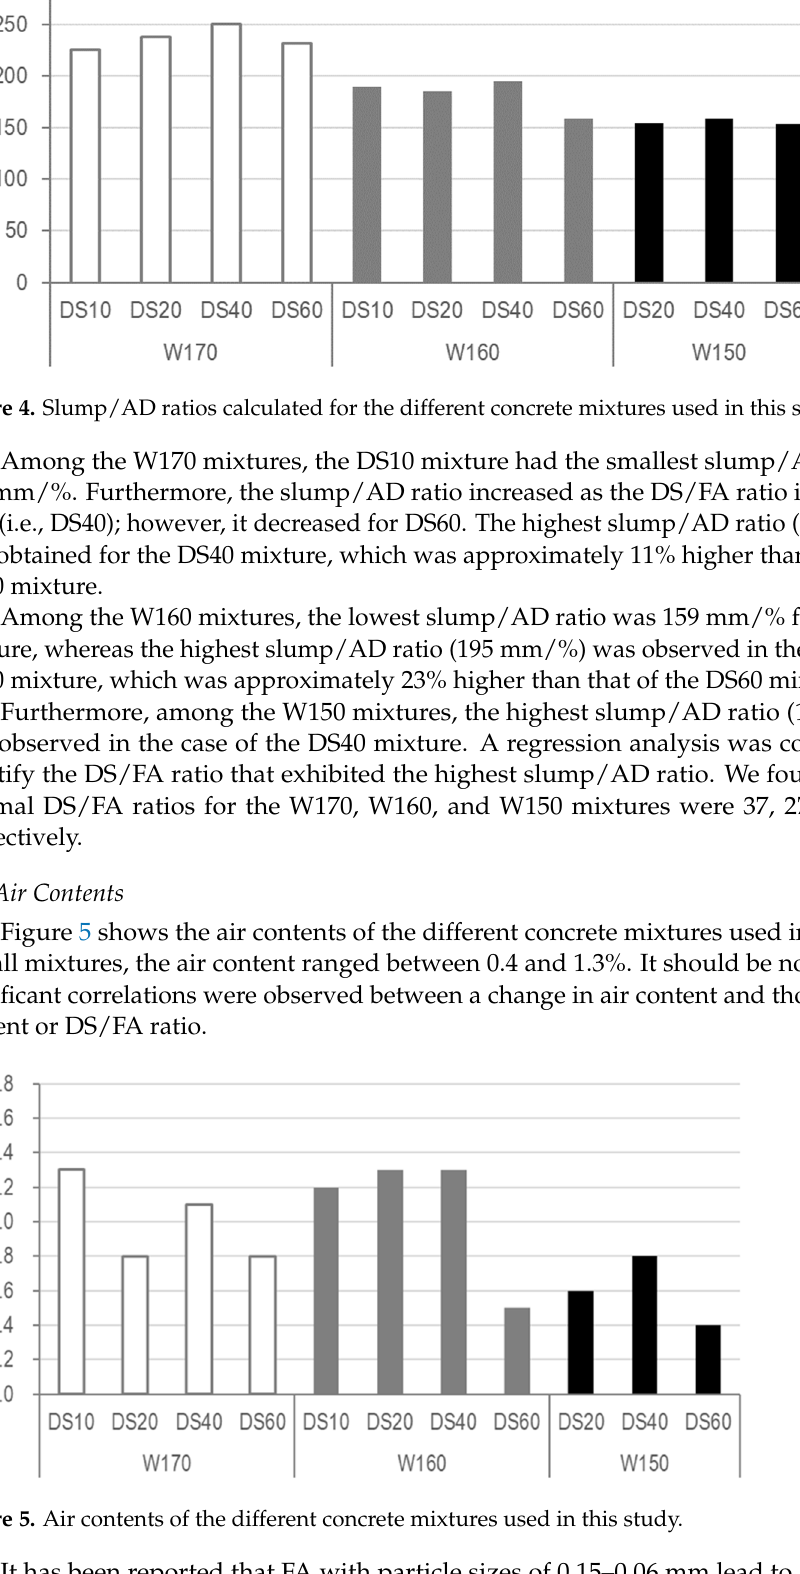
Figure 5. Air contents of the different concrete mixtures used in this study.